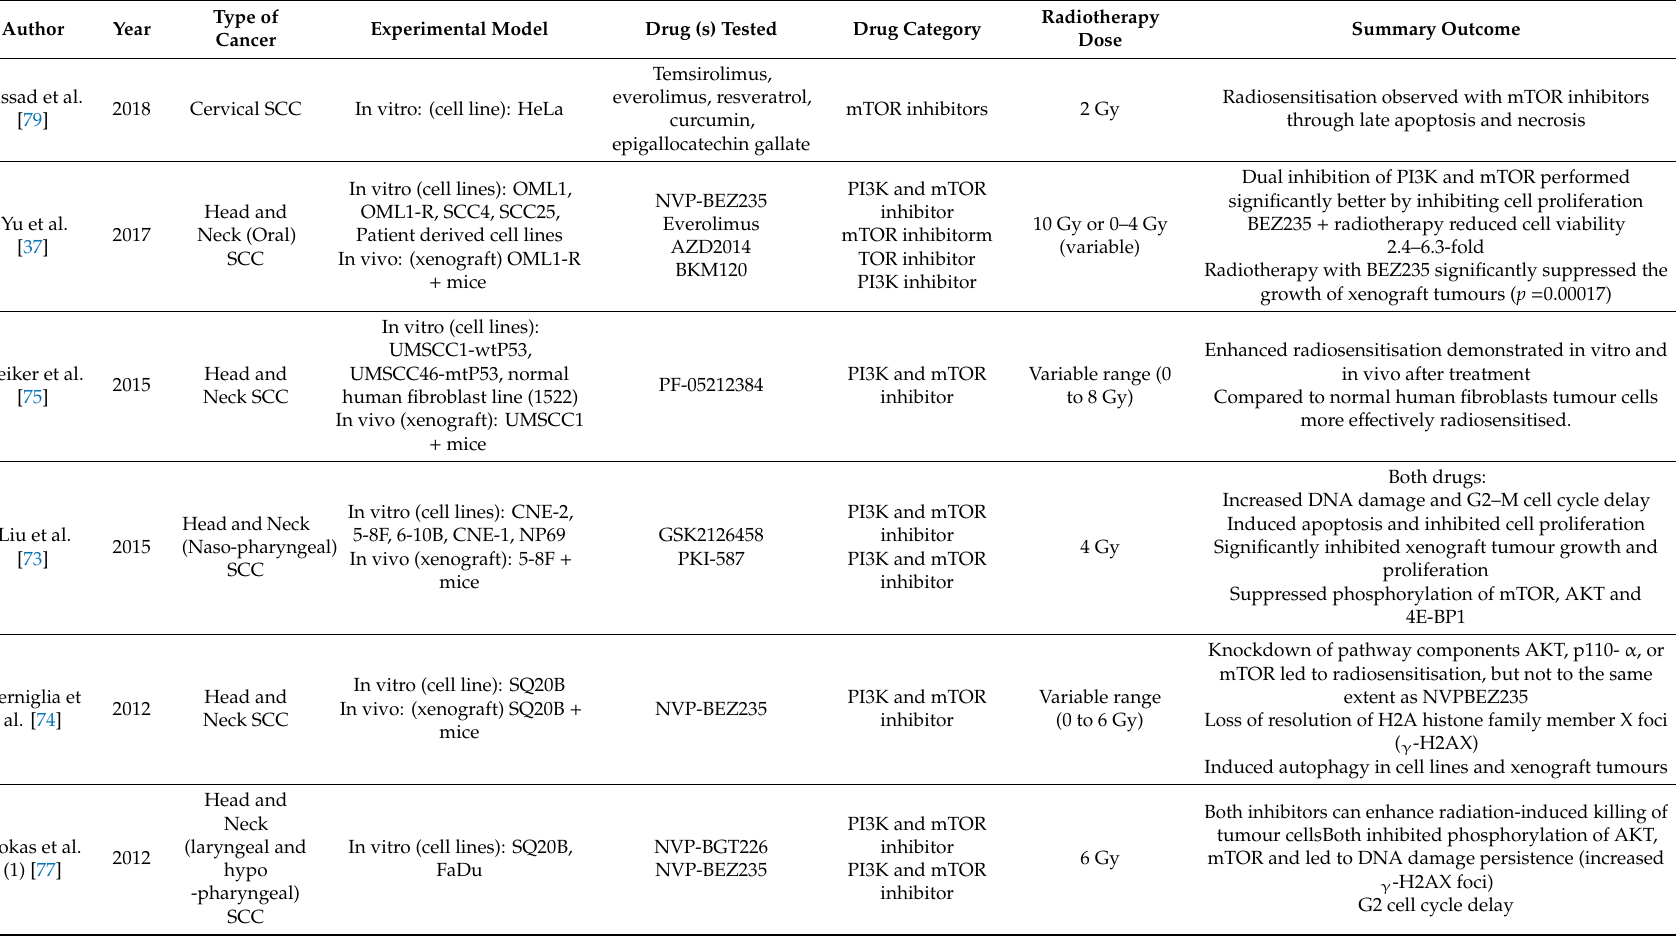
Table 2. Preclinical studies exploring the role of PI3K, AKT and / or mTOR inhibitors radiosensitising SCC and